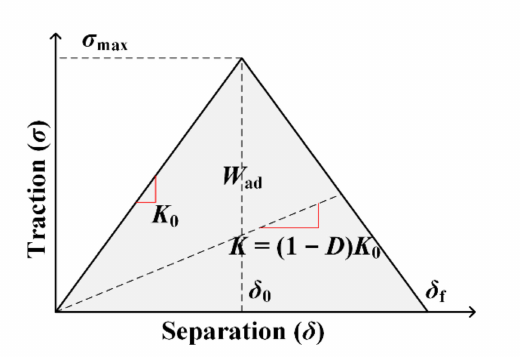
Figure 4. Bilinear traction–separation law in the cohesive zone model